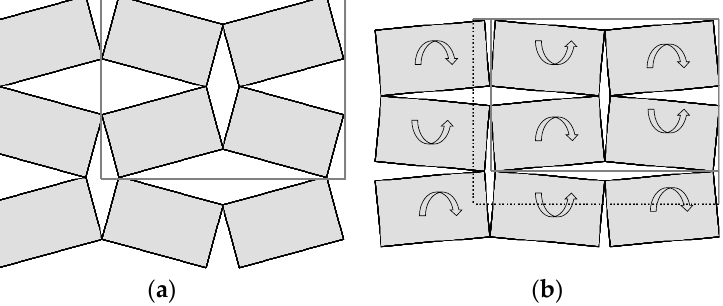
Figure 1. Illustration of the rotation mechanism of 2D structure with rotating unit cells, which creates NPR effect. Rigid units ( a ) before rotation and ( b ) after rotation.